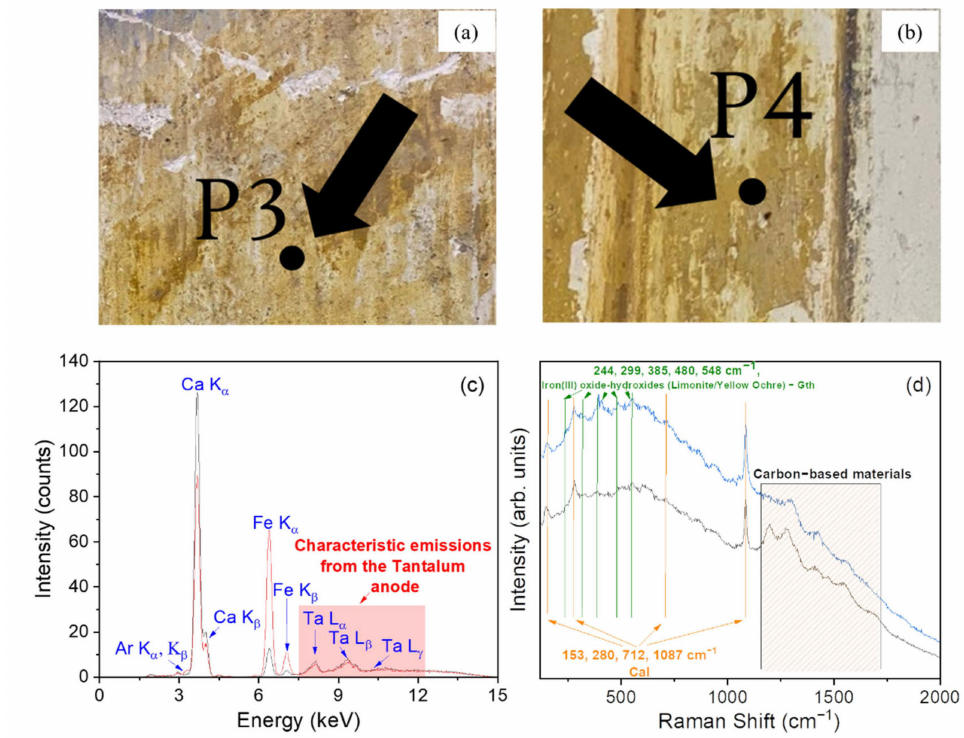
Figure 4. Photo of the point P3 (light yellow) ( a ). Photo of the point P4 (dark yellow) ( b ). XRF spectra recorded on the points P3 (black line) and P4 (red line) ( c ). Raman spectra recorded on the points P3 (gray line) and P4 (blue line) ( d ). In the figure, Gth: goethite; Cal: